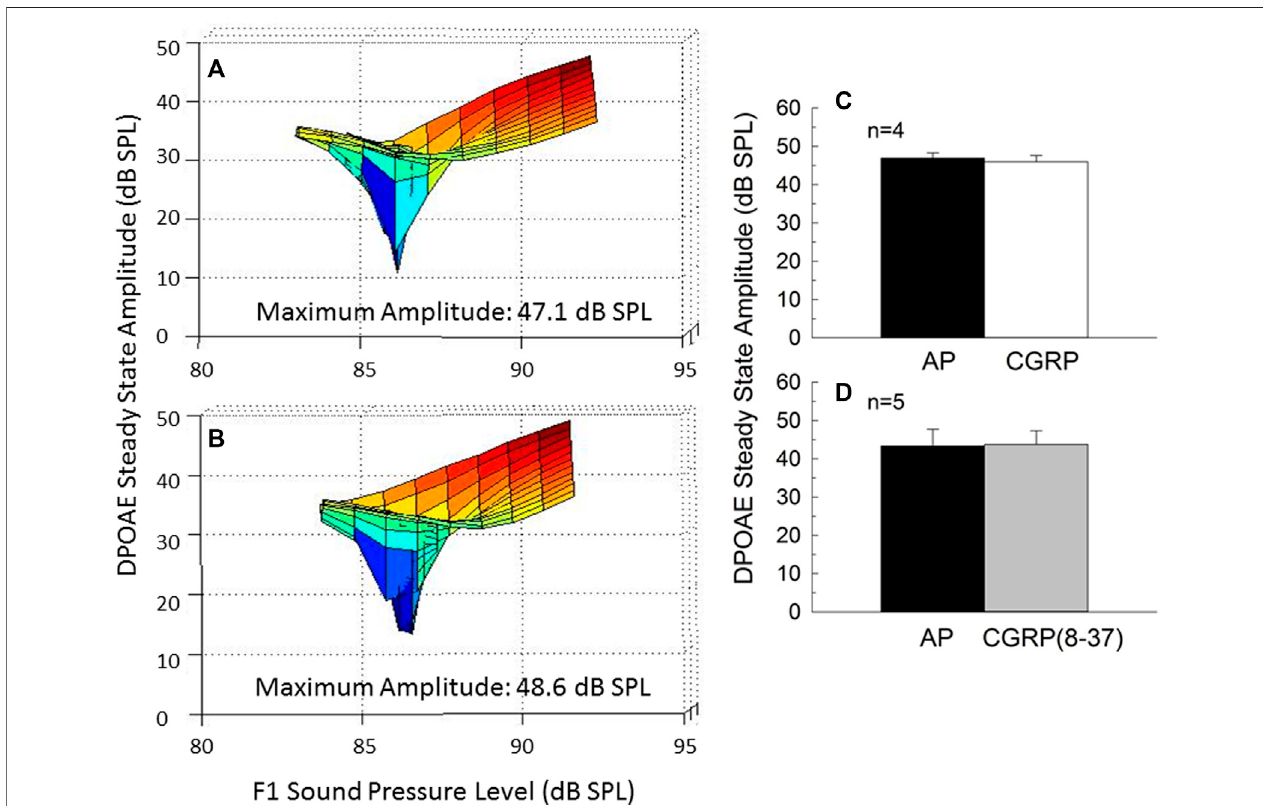
FIGURE 6 | Steady-state amplitude of the outer hair cell distortion product otoacoustic emission (DPOAE) varies with F1 and F2 sound level, and provides as a measure of the integrity of the outer hair cell population. DPOAE amplitude is depicted on day 9 of arti fi cial perilymph (A) and CGRP (B) infusion for one representative animal. The steady state amplitude was extracted from the fi ne-structure plots shown in (A,B) . The level-dependent steady-state DPOAE amplitude was unchanged by either CGRP (C) or CGRP (8 – 37) (D) infusion (all p ’ s > 0.05).